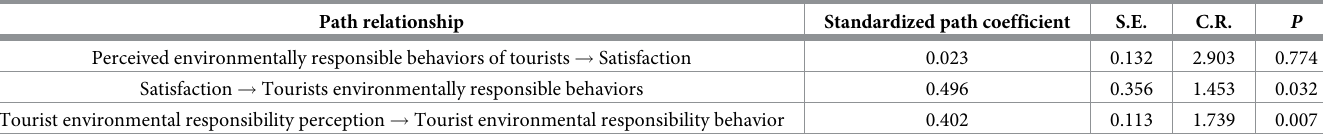
Table 16. Tourist model path analysis.